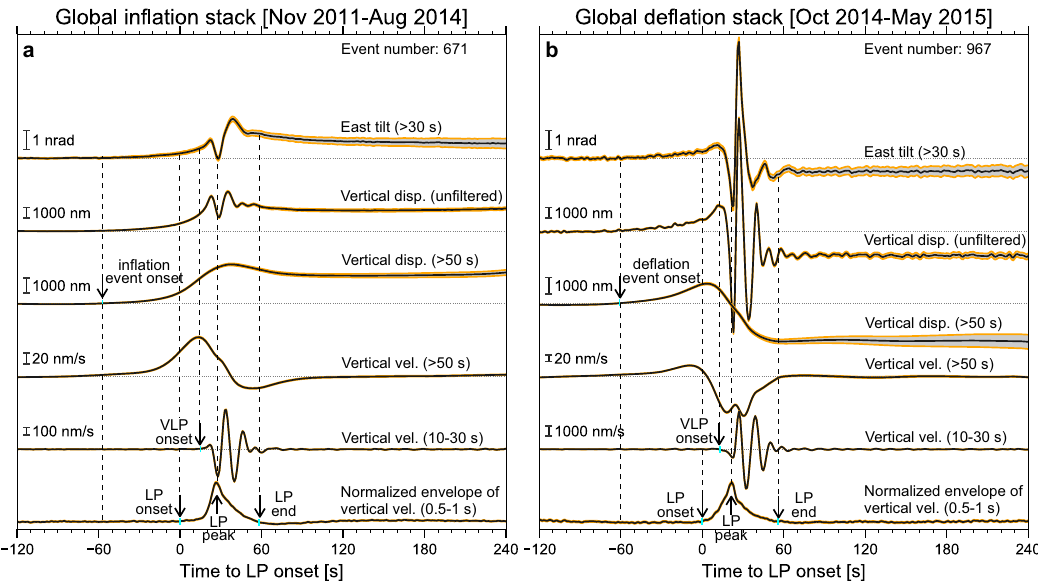
Fig. 2 Observations of global waveform stacks against VLP and LP. a Global waveform stacks from in fl ation events in the subset I. b Global waveform stacks from de fl ation events in the subset I. Broadband tilt, displacement, and velocity of global waveform stacks at station N.ASHV are presented against VLP velocity waveform stacks (10 – 30 s) and LP envelope stacks (0.5 – 1 s). The yellow strip marks the bootstrap uncertainties at the 99.7% con fi dence level. These waveforms and envelopes are aligned against the onset time of LP envelope stack. To preserve the phase of the long-period waveform (>50 s), a 2 nd -order acasual Butterworth fi lter is implemented. We apply a 2 nd -order causal Butterworth fi lter to preserve the timing of the VLP waveform stack (10 – 30 s) and LP envelope stack (0.5 – 1